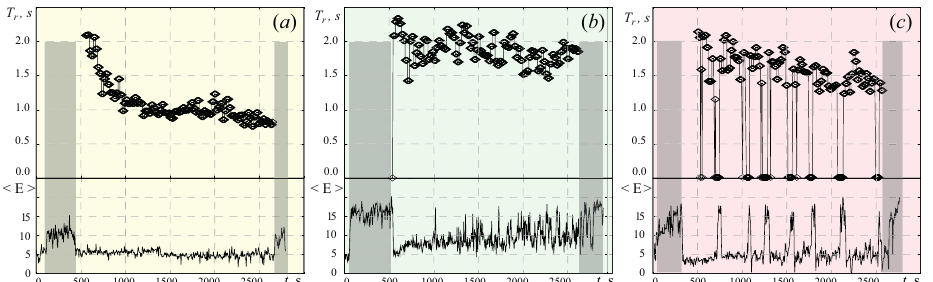
Figure 2. ( a ) The top panel: test subject response delays decreased with experimental time, over sub- sequent trials to the sound stimulus T r ( t ) on experimental time t ; the bottom panel: the dependence of wavelet energy (cid:104) E ( t ) (cid:105) in the frequency interval of [ 8;12 ] Hz. These dependences were calculated for test subject #7 from Group I (control group with a healthy sleep); ( b , c ) represent similar depen- dences of T r ( t ) and (cid:104) E ( t ) (cid:105) for test subject #11 from experimental Group II (with primary insomnia) and for test subject #3 from Group III (with hypersomnia), respectively. Light gray rectangles indicate CY and RCY stages (passive wakefulness of test subjects with closed eyes–initial and